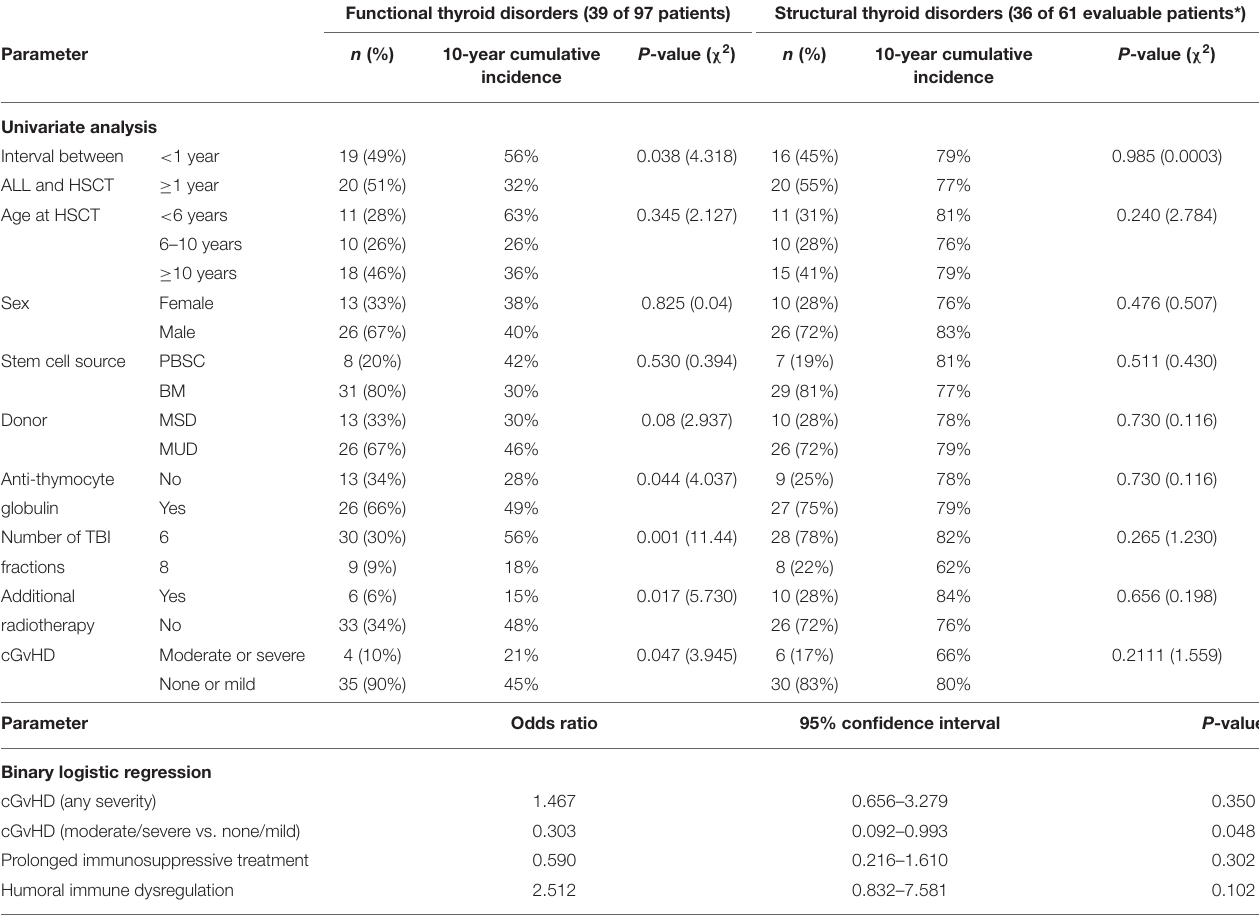
TABLE 2 | Correlation between thyroid disorders post TBI-based HSCT with patient and transplant characteristics (univariate analysis and binary logistic regression). Functional thyroid disorders (39 of 97